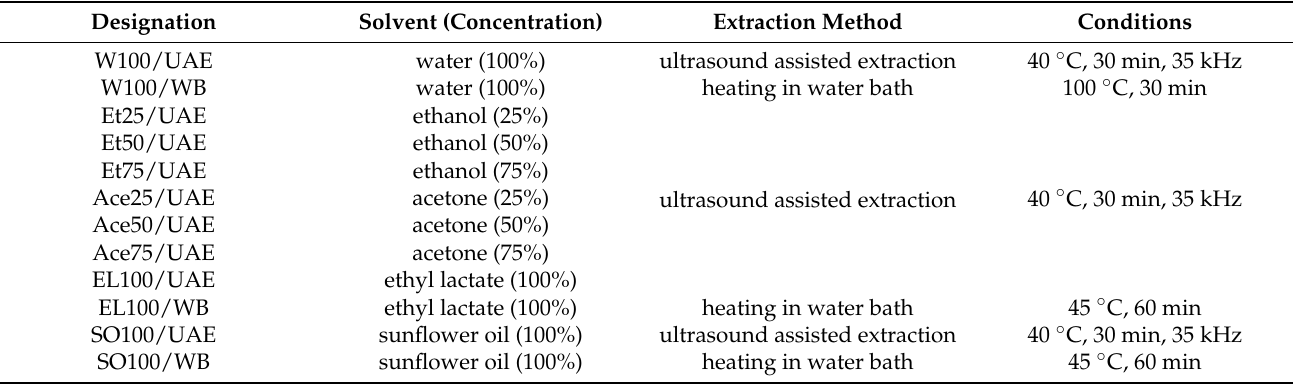
Table 2. Conditions for the extraction of goji